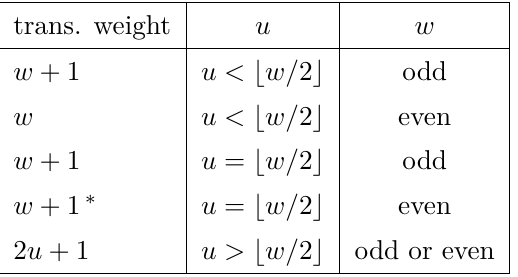
with integer u ≥ t ≥ s ≥ 2 and E ∗ E ∗ s t u